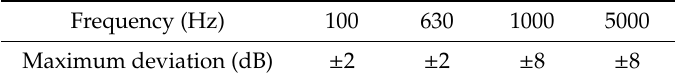
Table 2. The maximum deviation of directivity of source in decibels for excitation with octave bands of pink noise and measured in free field (ISO 16283-1, ISO 10140-5 and ISO 140-3 (withdrawn)).